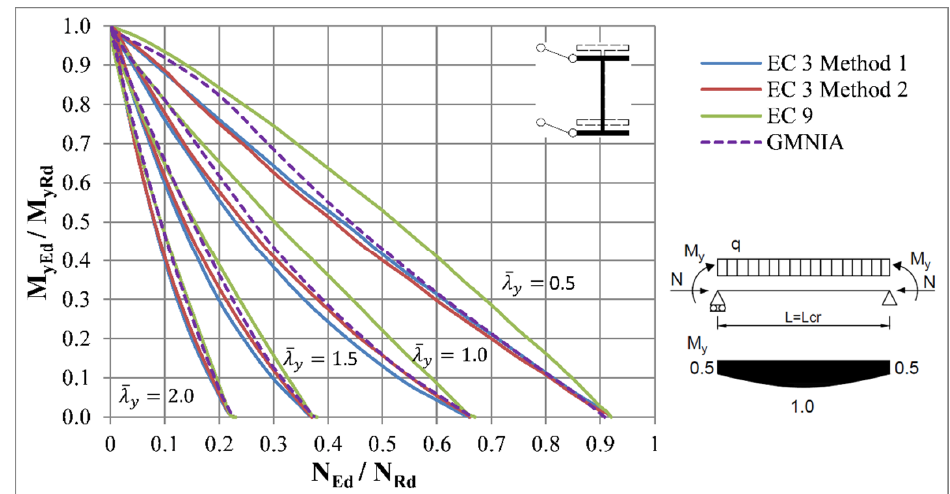
Figure 12. Interaction curves for laterally restrained beam-columns with IPE 100 cross-section. Nomenclature: (cid:2019)̅̅ —slenderness ratio for the appropriate buckling axis, N Rd , M y,Rd , M z,Rd —design